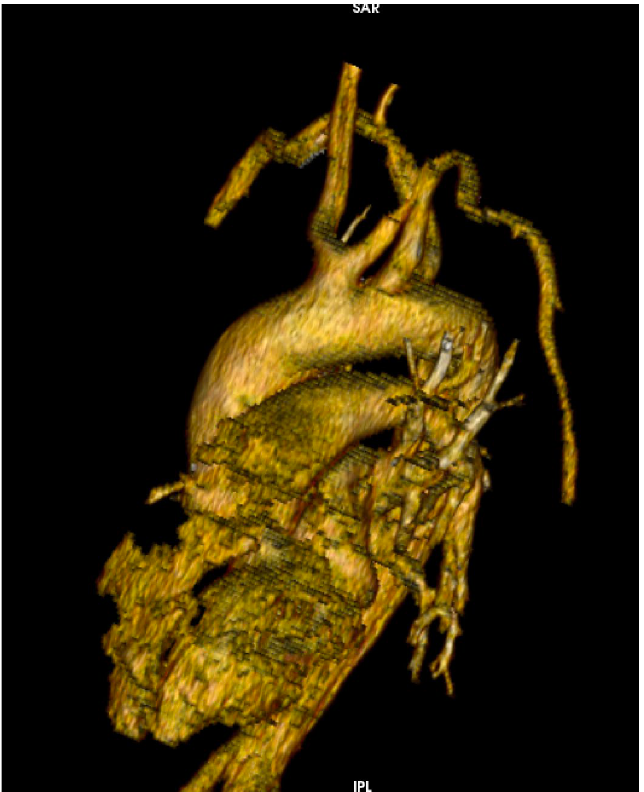
Figure 3. Arch anomaly—arteria lusoria and common origin of the innominate artery and left common carotid artery.